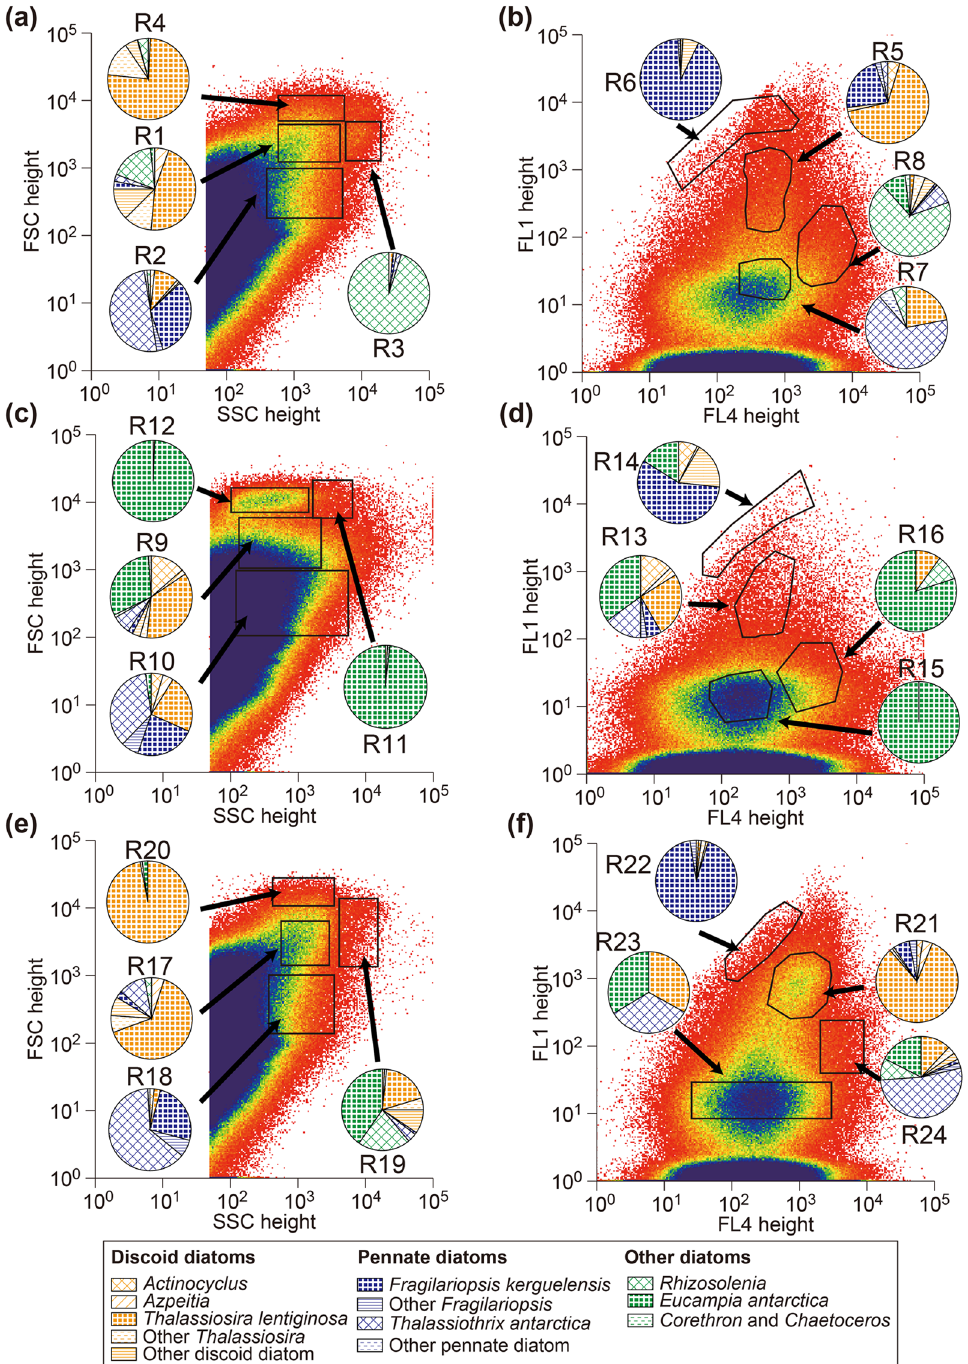
Fig. 4 Flow cytograms and pie charts showing the diatom assemblages obtained from each sorting region. The circled numbers indicate the sorting regions established in this study. a, b Sample 382-U1538A-1-2, 24–25 cm (Holocene). c, d Sample 382-U1538A-3-1, 24–25 cm (last glacial). e, f Sample 382-U1538A-5-6, 24–25 cm (last interglacial). Plots of FSC height versus SSC height are shown in ( a ), ( c ), ( e ), and FL1 height versus FL4 height are shown in ( b ), ( d ), ( f ). Each dot in the flow cytogram indicates a particle that passes through the laser: the bluer the color, the greater the number of